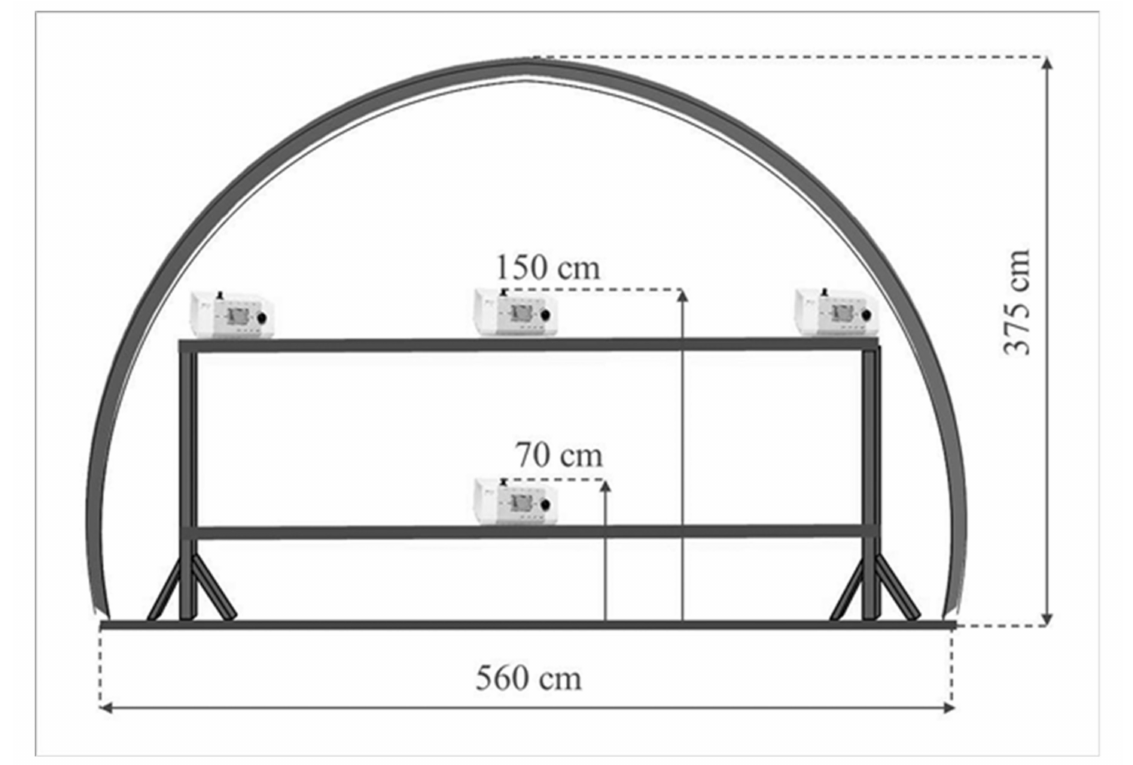
Figure 3. GIG Experimental Mine ‘Barbara’, level 30 m. The area of conducted research works and a view of the support structure for particle